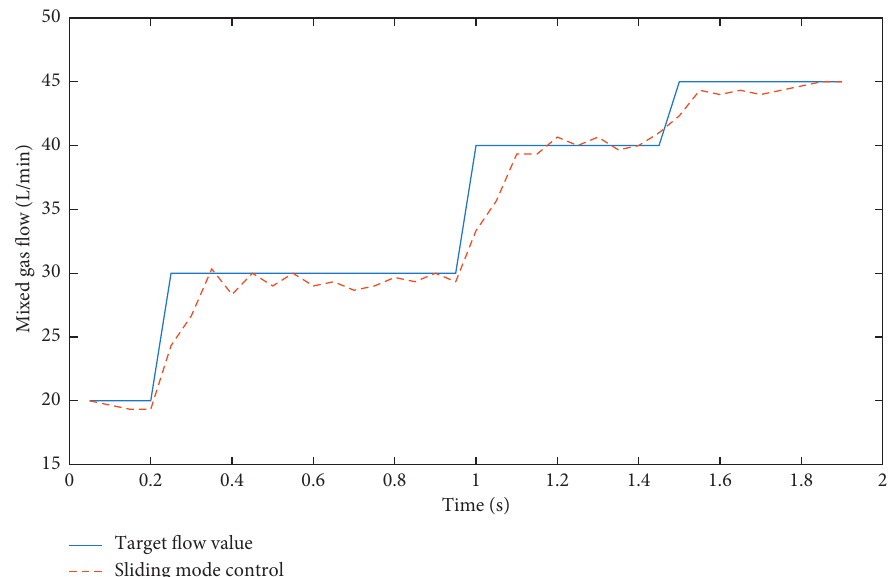
Figure 9: Comparison of continuous adjustment of total flow of mixed gas under sliding mode control.